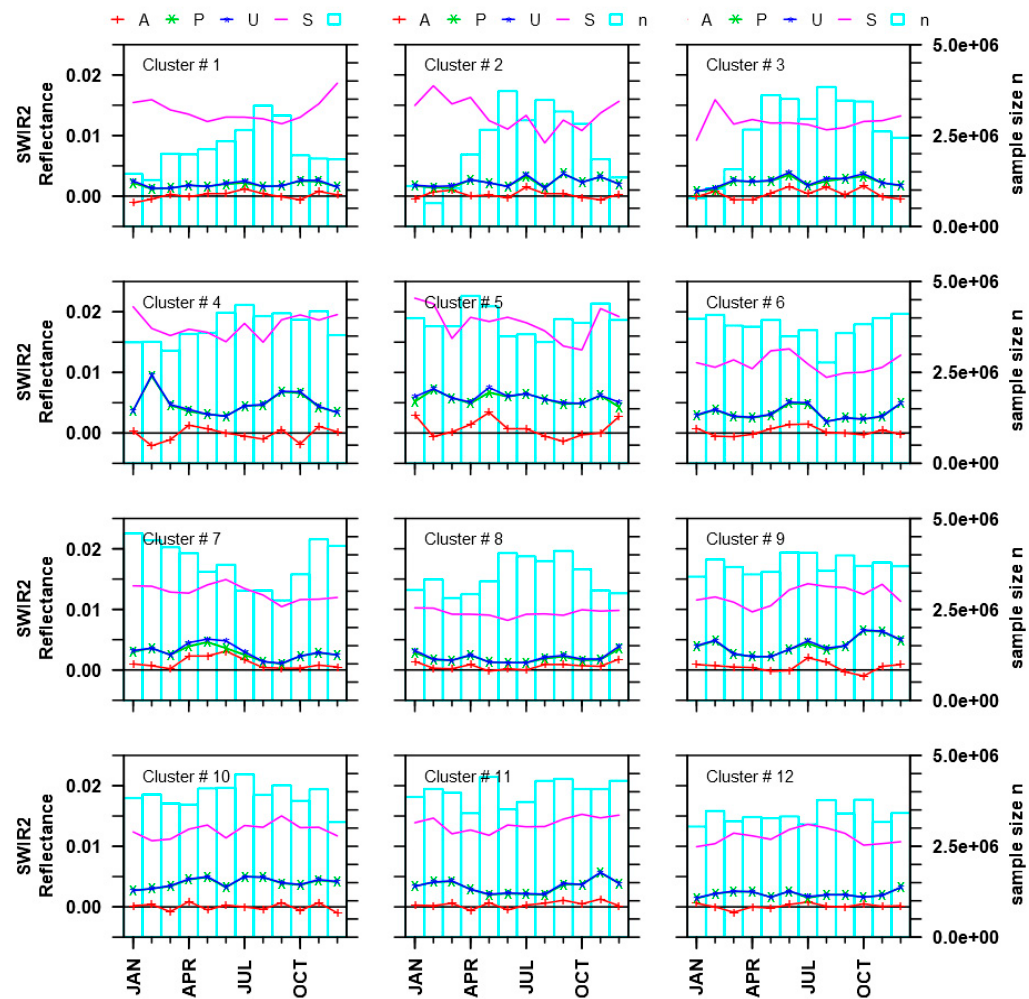
Figure 10. Accuracy, precision, and uncertainty (APU, left y-axis) for each season (x-axis) in each cluster (Figure 5) for the pooled Landsat 5–8 SWIR2 band. For each case (e.g., Cluster #1, January) an APU plot was generated, and visualized here are the overall APU statistics (which are shown as text in the legend of Figure 8). Colors and signatures are as in Figure 8. The cyan bars are the number of samples in each stratum (right y-axis). The magenta line represents the specified theoretical uncertainty based on the mean surface reflectance truth.